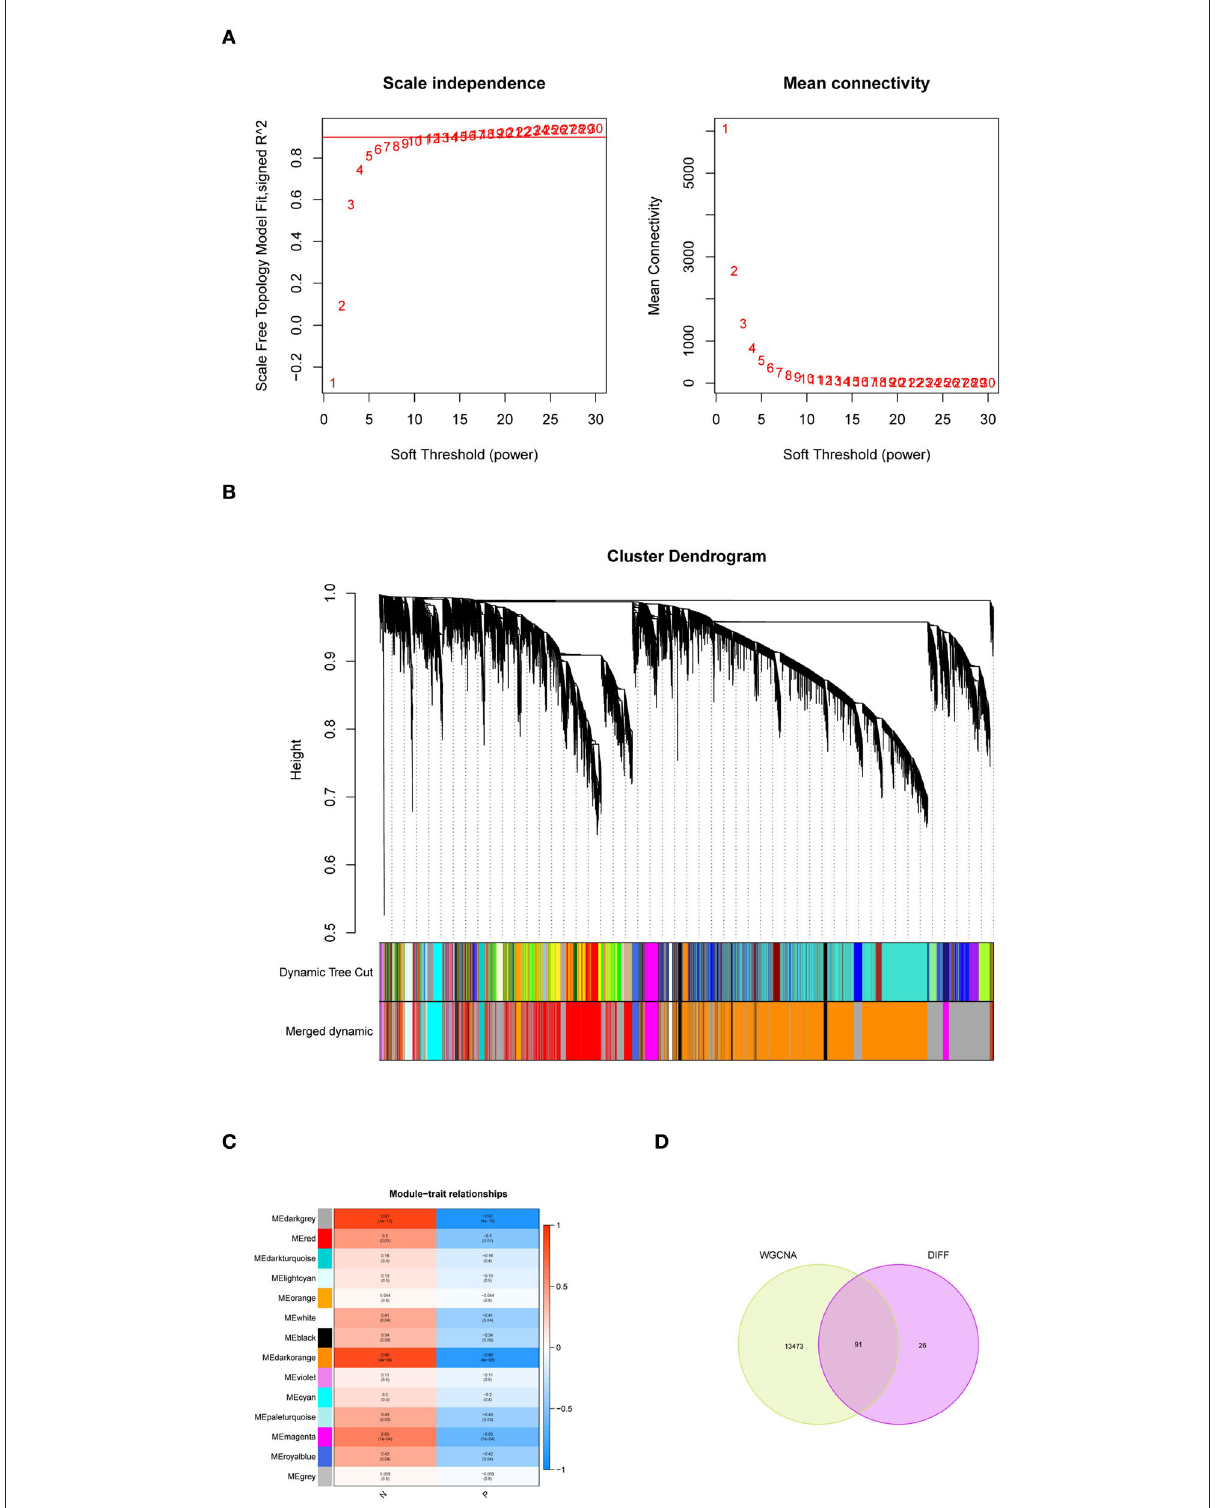
FIGURE2 Weighted gene co-expression network analysis (WGCNA). (A) Soft threshold analysis suggested gene associations were maximally consistent with the scale-free distribution when β = 26. (B) The cluster dendrogram of co-expression genes in PD. (C) Module-trait relationships in PD. Each cell contains the corresponding correlation and P -value. (D) A Venn diagram was made to obtain the intersection of the target genes screened by the two